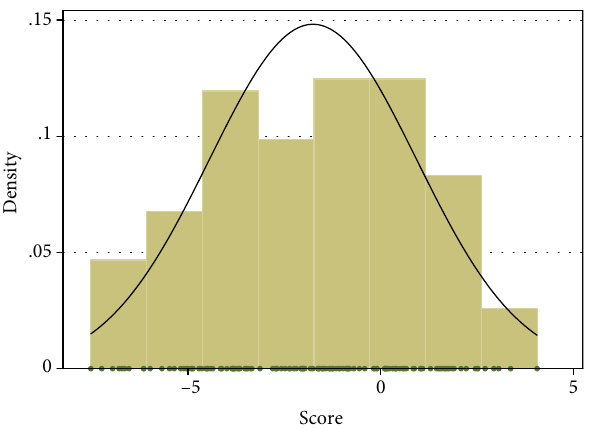
Figure 3: Distribution of diabetic foot ulcer predicting score in the studied cases. Mean = − 1 : 759 , standard deviation = 2 : 692 , minimum = − 7 : 525 , maximum = 4 : 057